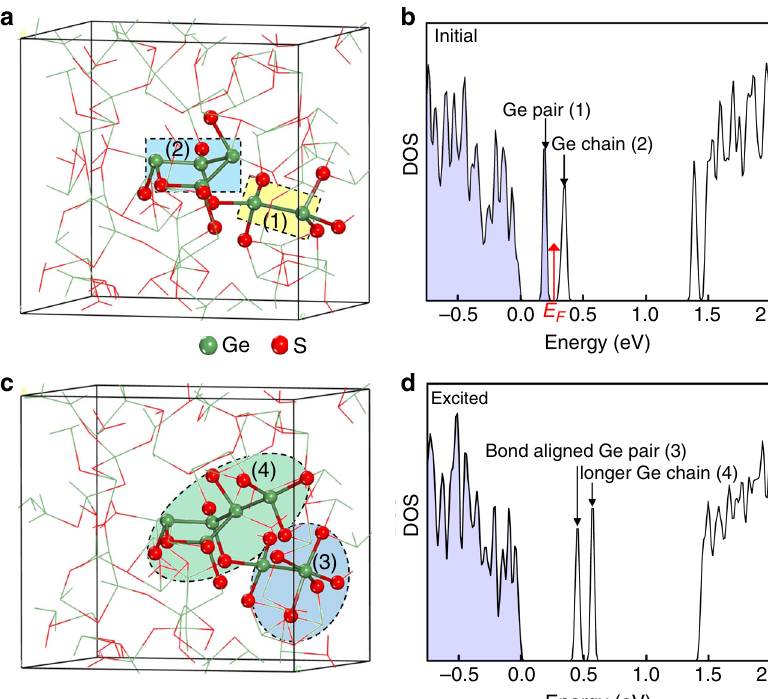
Fig. 6 First-principles simulation of the switching mechanism. Evolution of the structure and the corresponding DOS for amorphous GeS ( a , b ) before and ( c , d ) after hole excitation. The dotted boxes (1) and (2) highlight the Ge pair and Ge chain before excitation, creating one fi lled and one empty trap state, respectively. The dotted circles (3) and (4) highlight the bond aligned Ge pair and longer Ge chain,